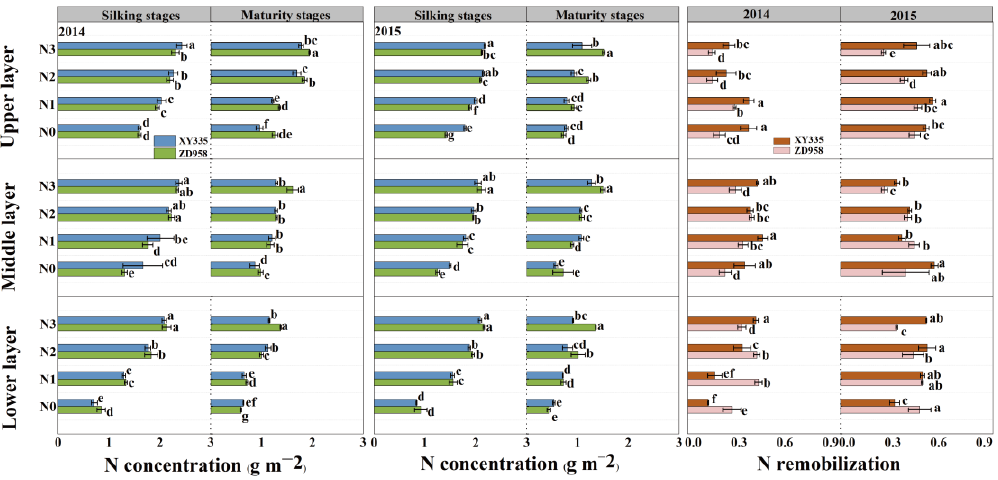
Figure 3. N content and remobilization in di ff erent maize genotypes at a high plant density in 2014 and 2015. N0, N1, N2, and N3 indicate applications of 0, 100, 200, and 300 kg N ha − 1 , respectively. Di ff erent le tt ers indicate a signi fi cant di ff erence at the 5% level. Values are shown as the mean ± SE ( n = 3).